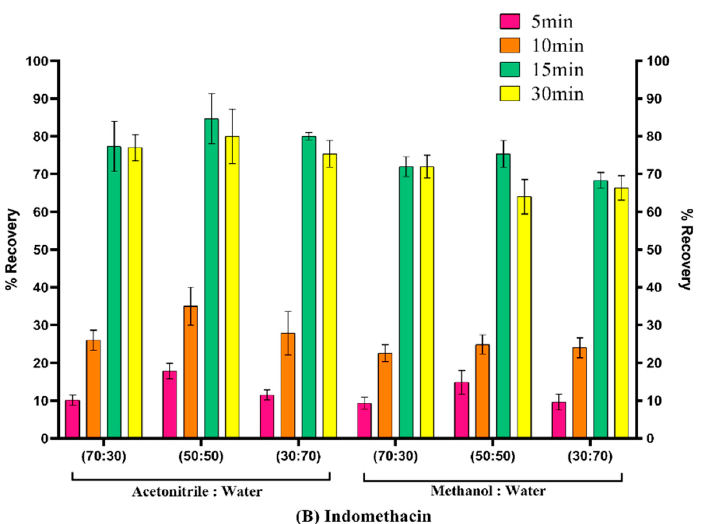
Figure 7. Optimization of extraction recovery of ( A ) acetaminophen and ( B ) indomethacin by using solvents acetonitrile: water (70:30, 50:50, 30:70) and methanol: water (70:30, 50:50, 30:70).